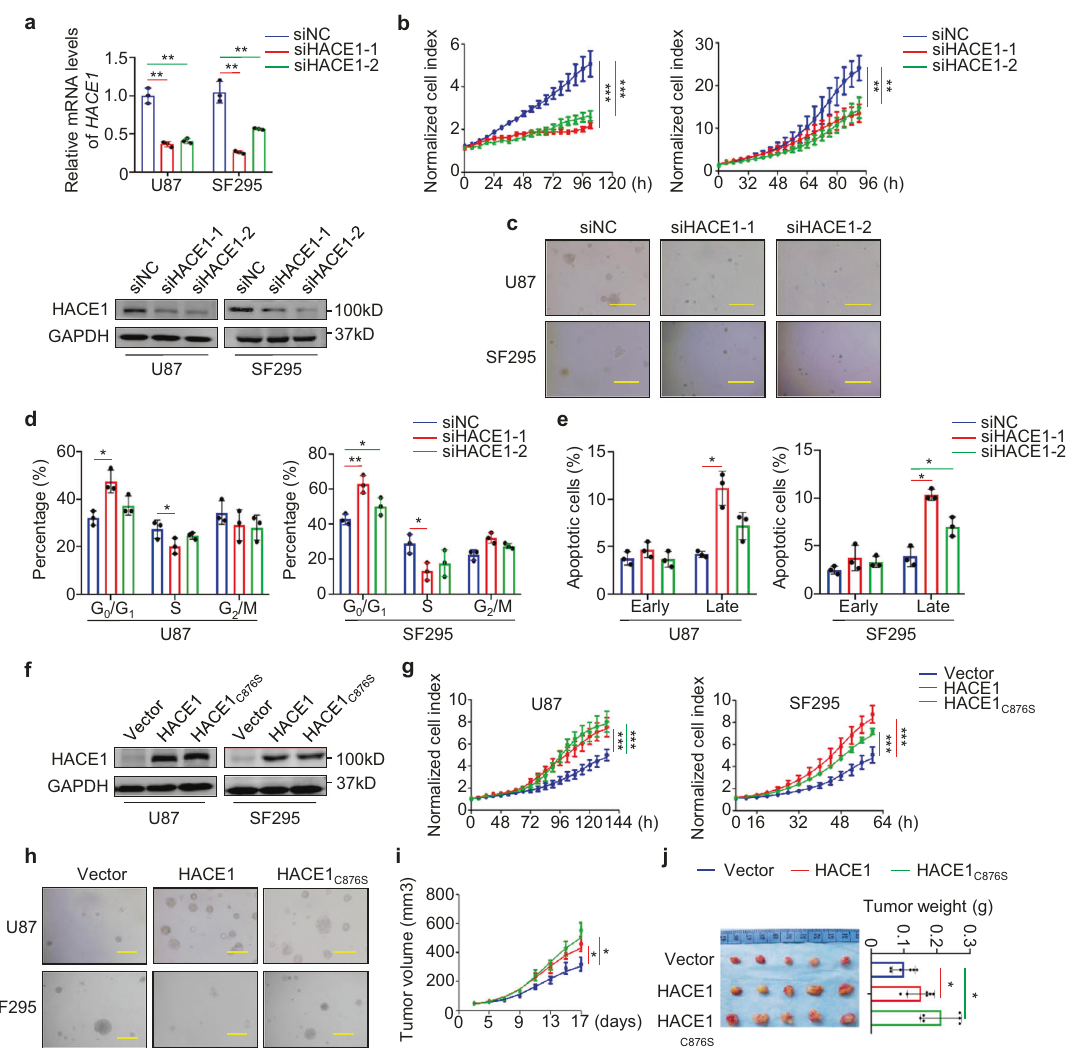
Fig. 2 Oncogenic role of HACE1 in glioma. a Inhibition of HACE1 expression by two different siRNAs targeting HACE1 (si-HACE1-382 and si- HACE1-854) in SF295 and U87 cells was validated by qRT-PCR and western blot assays with 18S rRNA and GAPDH as the normalized controls. b The proliferation of HACE1 kncokdown-U87 and SF295 cells and control cells was monitored by the iCELLigence system. c Colony formation assays of HACE1 kncokdown-U87 and SF295 cells and control cells. Scale bars, 200 μ m. Cell cycle ( d ) and apoptosis ( e ) assays of HACE1 kncokdown-U87 and SF295 cells and control cells by fl ow cytometry. f Western blot analysis con fi rms ectopic expression of HACE1 or HACE1 C876S in SF295 and U87 cells. GAPDH was used as a loading control. Cell proliferation ( g ) and colony formation ( h ) assays of HACE1- overexpression cells and control cells. i Tumor growth curves in nude mice were compared between HACE1/HACE1 C876S -overexpression-U87 cells and control cells ( n = 5/group). j Left panel: representative images of xenograft tumors; right panel: statistical results of tumor weight in HACE1/HACE1 C876S -overexpression and control mice. Data were expressed as mean ± SD. * P < 0.05; ** P < 0.01; *** P <